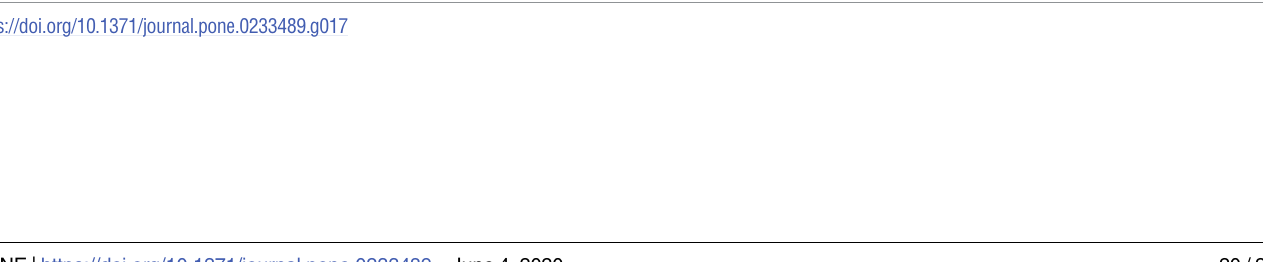
PLOS ONE | https://doi.org/10.1371/journal.pone.0233489 June 4,